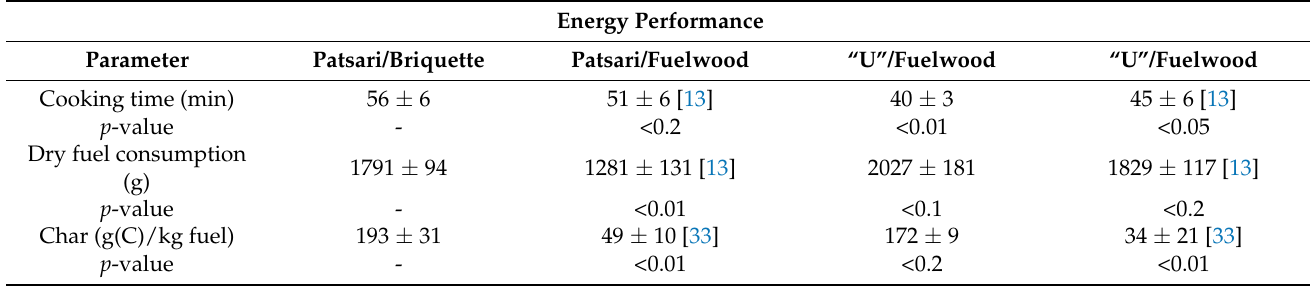
Table 4. Comparative performance parameters of Patsari/Briquette and “U” type/fuelwood for cooking tortillas in a Controlled Cooking Tests.